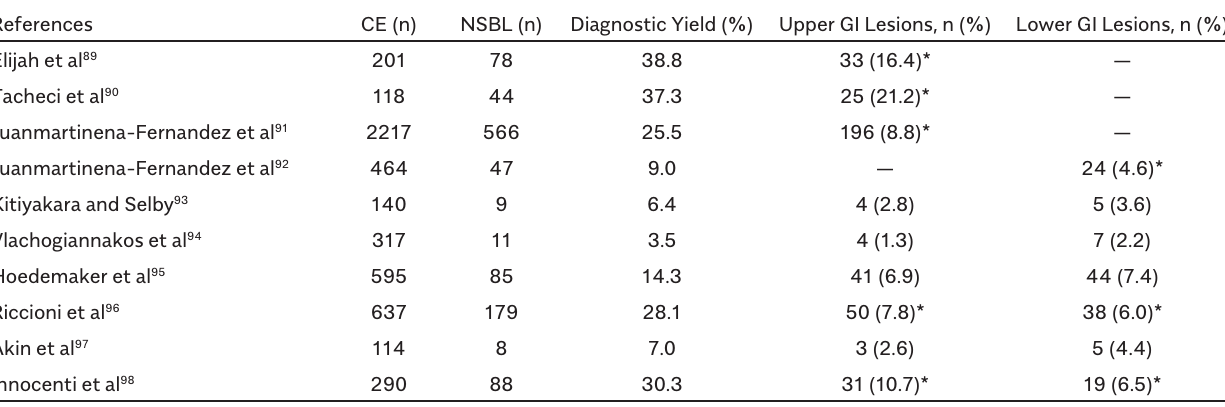
Table 2. Studies Evaluating the Rate of NSBLs Detected by